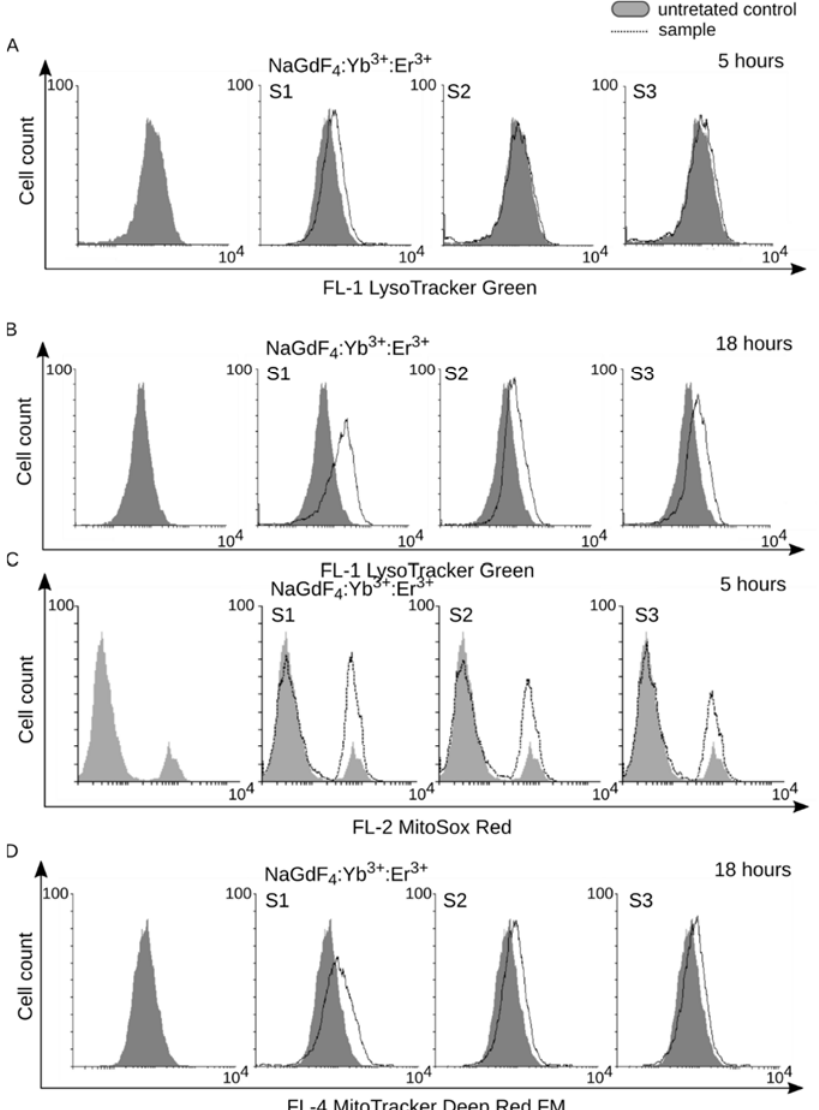
Figure 5. ( A , B ) Lysotracker analysis of cells treated with NaGdF 4 :Yb 3+ ,Er 3+ NPs (1 µ g/mL) after 5 h and 18 h. A shift to the right indicates an increase of cell acidic compartment; ( C ) Induction of superoxides after a 5-h treatment with NPs detected by staining with the MitoSOX probe; ( D ) Increase of mitochondrial compartment; staining with the Mitotracker probe after an 18-h treatment with NPs. Representative histograms are shown ( n = 3).